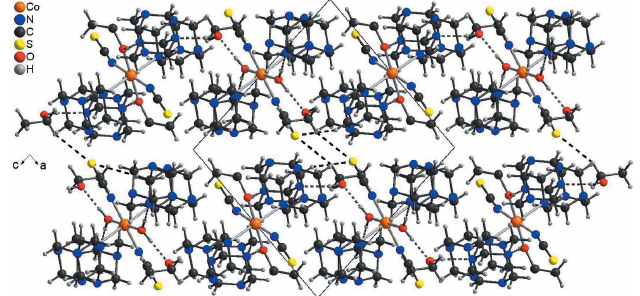
Figure 6 Crystal structure of compound 1 with a view along the crystallographic b axis and intermolecular hydrogen bonding shown as dashed